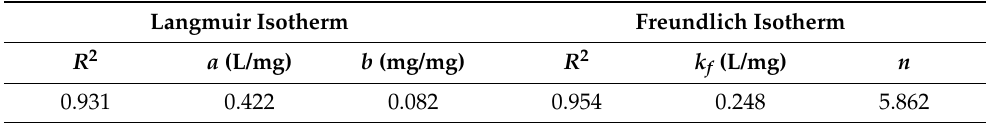
Table 2. Adsorption isotherm modeling for the removal of Cr(VI) from aqueous solution using CNCs as an